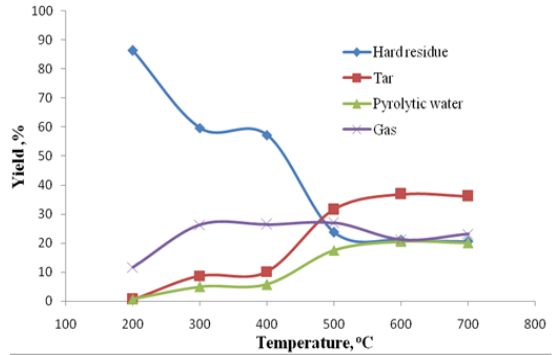
Fig. 2. FTIR spectra of biochar of